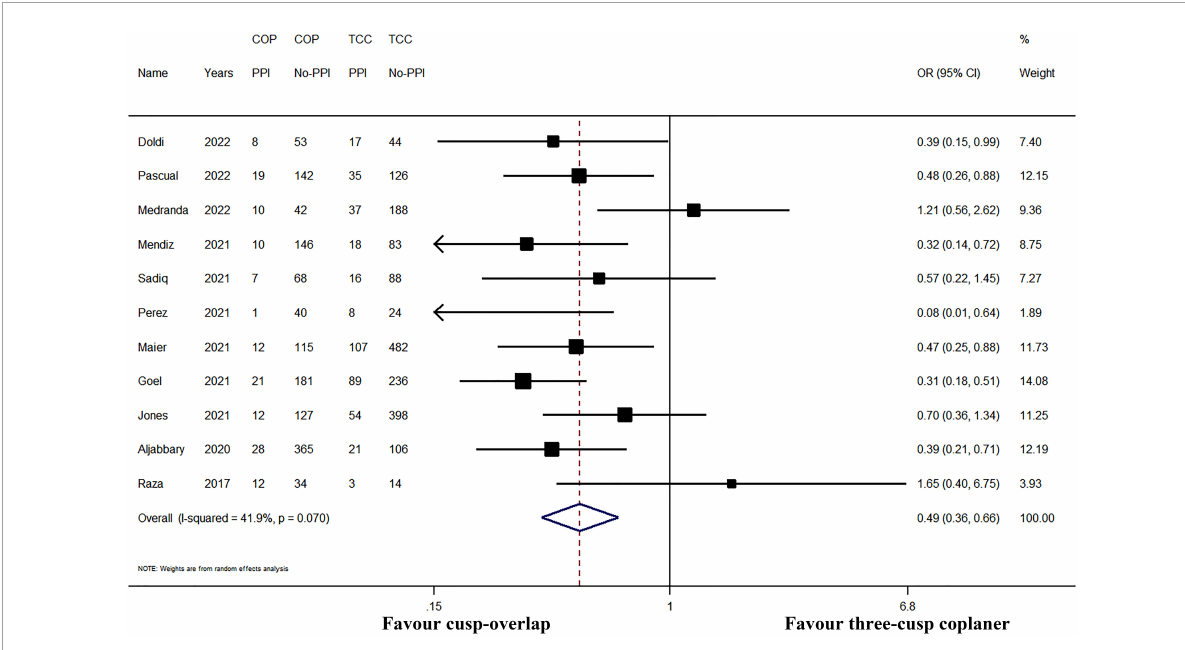
FIGURE3 Meta-analysis of the primary outcome of interest. CI, confidence interval; COP, cusp-overlap projection; OR, odds ratio; PPI, permanent pacemaker implantation; TCC, three-cusp coplanar. Forrest plot has shown the comparison of post-operative PPI. Since significant heterogeneity existed (heterogeneity Chi-square p = 0.070), a random-effects model was used. The bars represented a 95%